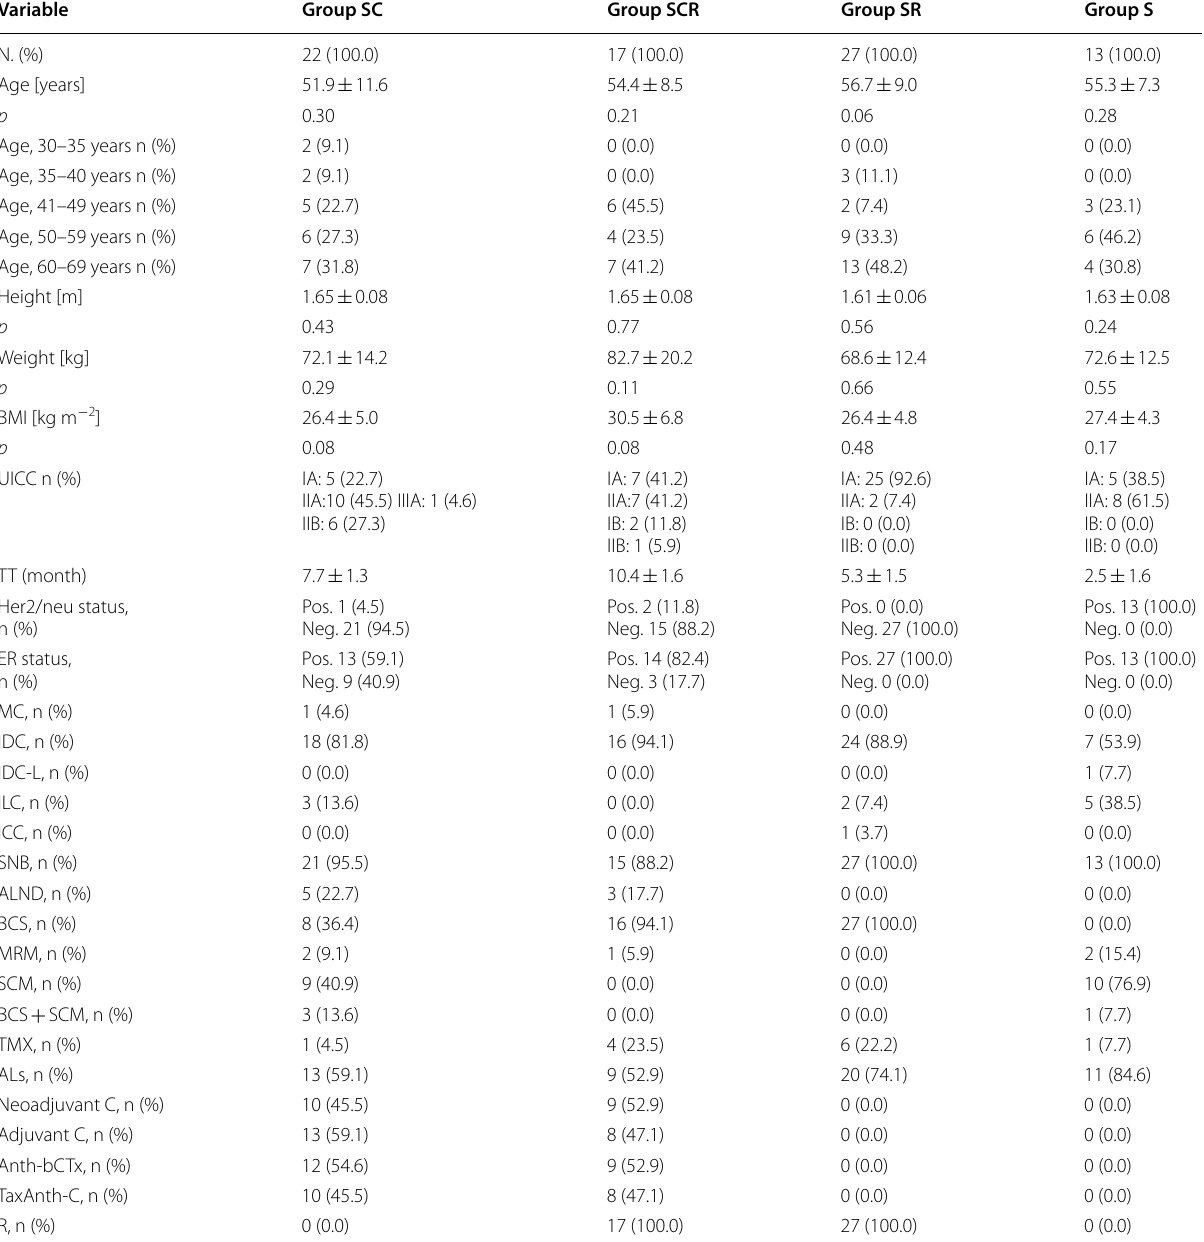
79 women with breast =